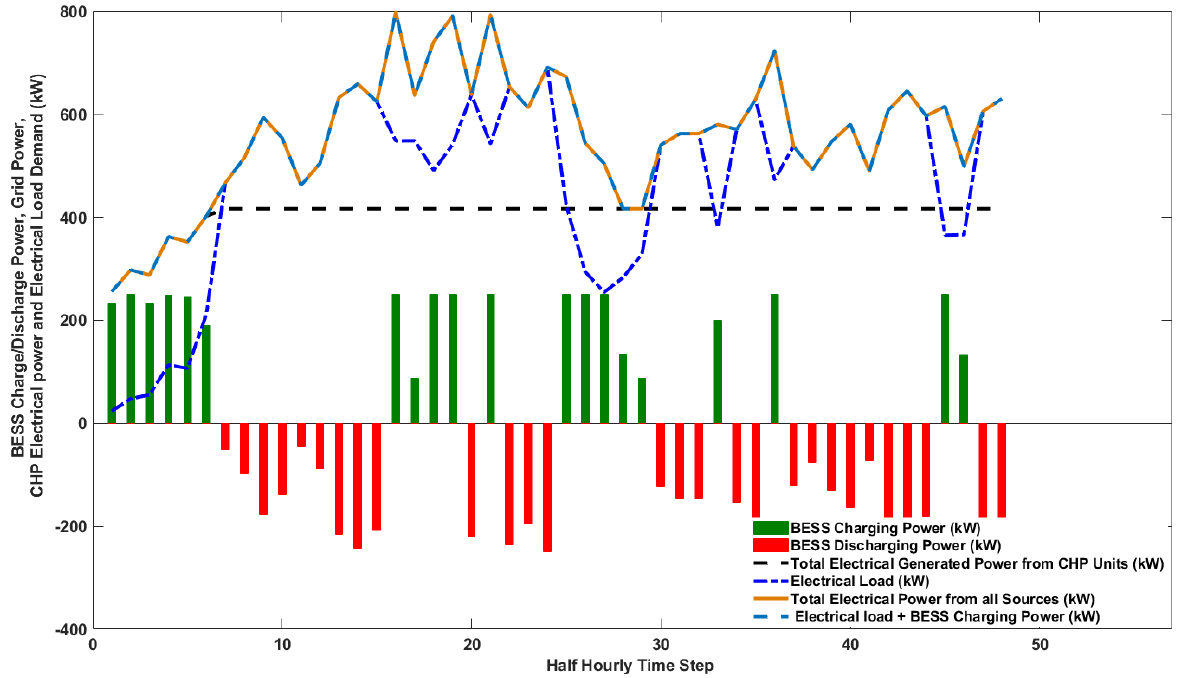
Figure 16. Total electrical power generated, real-time load demand, and BESS charge/discharge command (scenario 4).